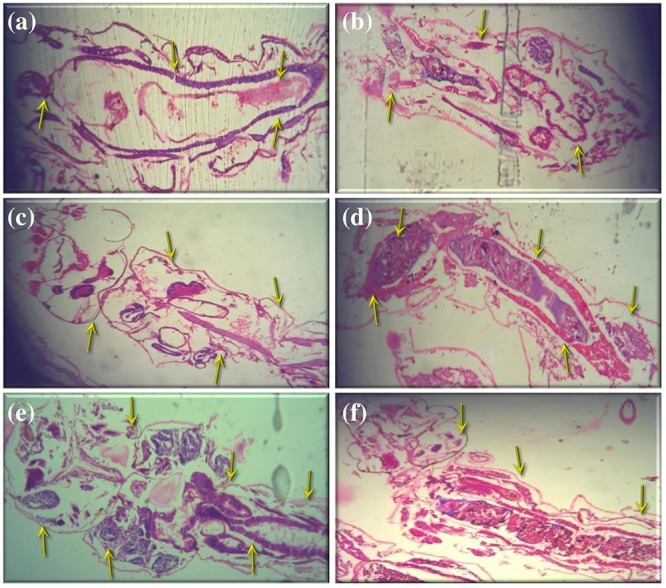
Histopathological analyses of treated and untreated fourth instar larvae of An. stephensi, Cx. quinquefasciatus, and Ae. aegypti: (a,c,e). Control larvae (b,d,f). A. terreus mycelium extract treated at (500 μg/ml) concentration against An. stephensi, Cx. quinquefasciatus, and Ae. aegypti. The yellow arrow indicates the whole abdominal region was collapse, mainly mid-gut and caeca, observed results revealed the loss of lateral and caudal hairs.